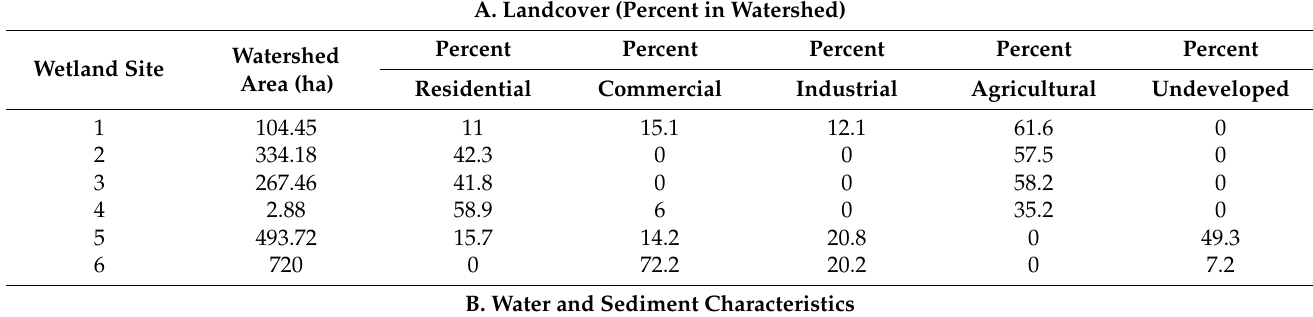
Table 1. Wetland site, water quality characteristics, and organic matter (OM) percent monitored on ten separate days between June and August 2017 of wetland sites 1–6 in the Pike river watershed (adapted from [35]). A. Landcover (Percent in Watershed) Wetland